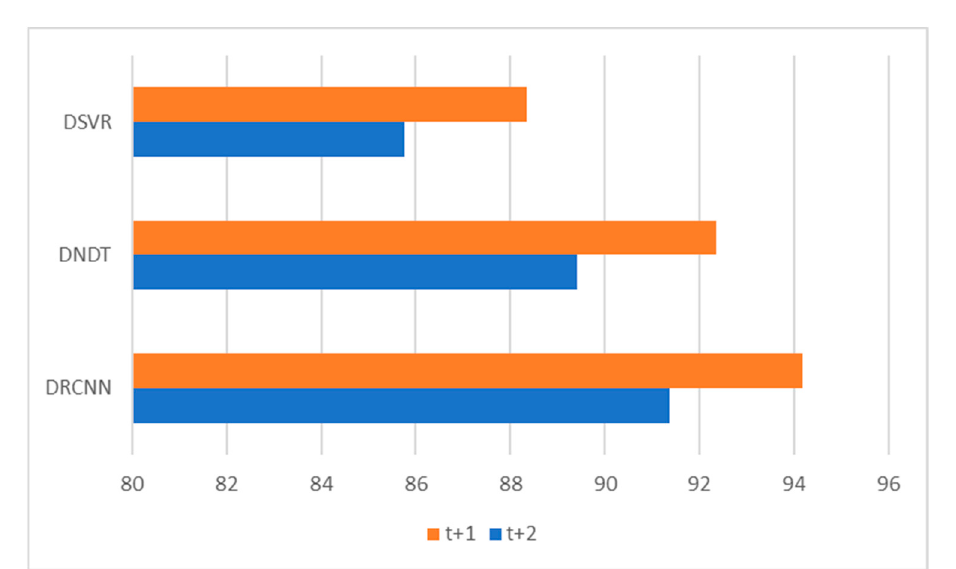
Figure 4. Multiple-step ahead forecasts in forecast horizon: accuracy. Mathematics 2020 , 8 , x FOR PEER REVIEW